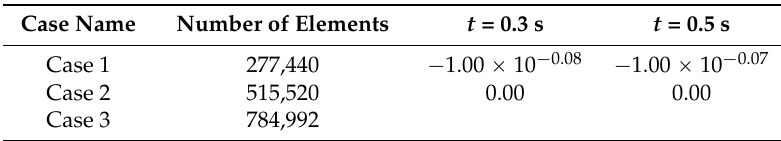
Table 3. Difference of maximum Von Mises strain between solution of Case 3 and two other cases ( t is time value).